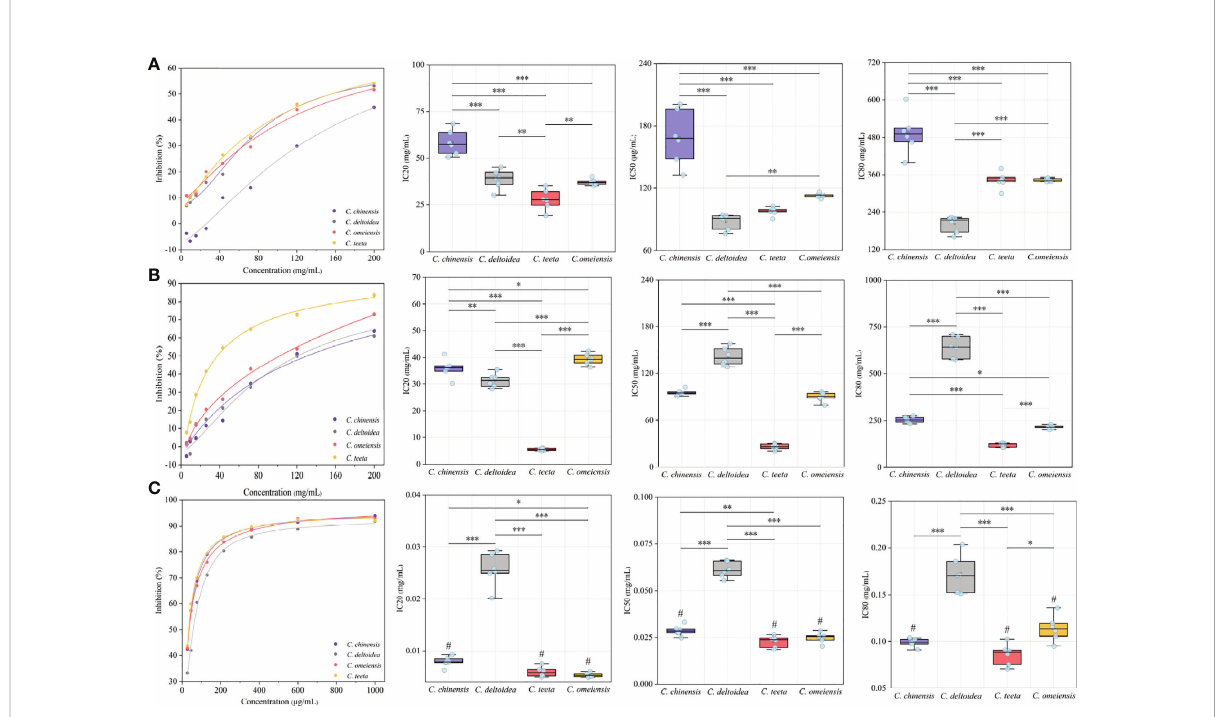
FIGURE 2 The results of in vitro inhibitory assays. This fi gure presents the AChE inhibitory curve and their IC 20, IC 50 and IC 80 of petroleum ether, ethyl acetate and n-butanol fractions of RC drugs for four Coptis species. The inhibitory curves were constructed by diluting the test solution in a 60% gradient. The letters of (A – C) represent the inhibitory of petroleum ether, ethyl acetate and n-butanol fractions of different RC drugs, respectively. The mark of “ # “ means the AChE inhibition of this extract is stronger than that of positive drug. The meaning of *, **, *** symbol is P<0.05, P<0.01, P<0.001,